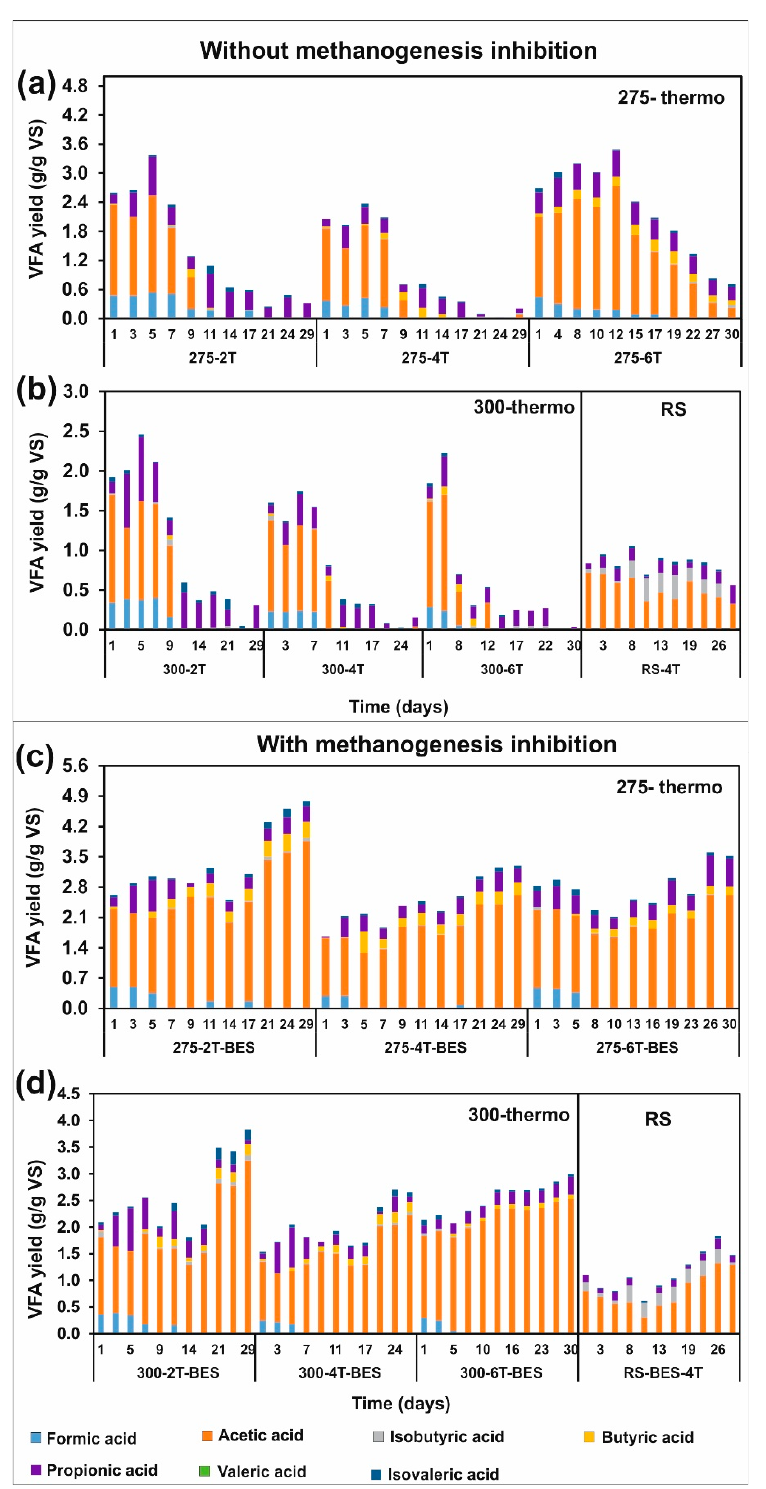
Figure 4. Volatile fatty acids production for the thermophilic process at various substrate loading for torrefaction condensate produced at 275 and 300 °C; ( a , b ) without methanogenesis inhibition and ( c , d ) with methanogenesis inhibition. The 2, 4, 6 represent substrate loading (g VS/L); RS represents raw sludge. For example, 275 − 2T − BES is for condensate produced at 275 °C, thermophilic conditions, 2 g VS/L loading and methanogenesis inhibition.